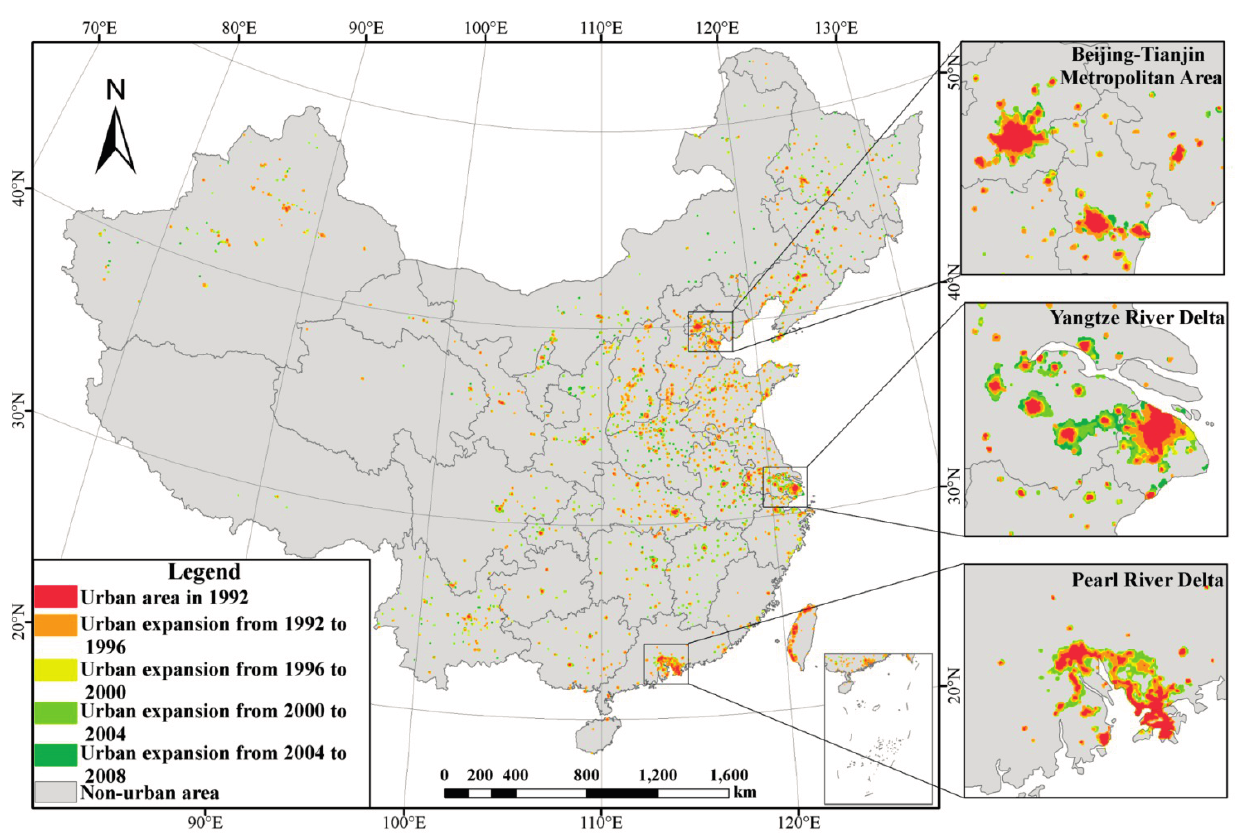
Figure 3. The dynamics of urban expansion in China derived from the DMSP/OLS nighttime light data from 1992 to 2008 (Source: Liu et al.